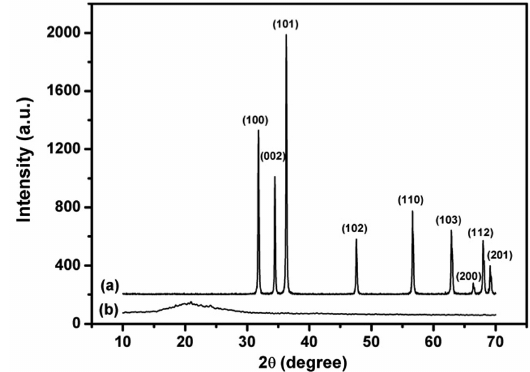
Figure 4. X-ray diffraction patterns obtained for: (a) ZnO (b) ZnO / PPy.